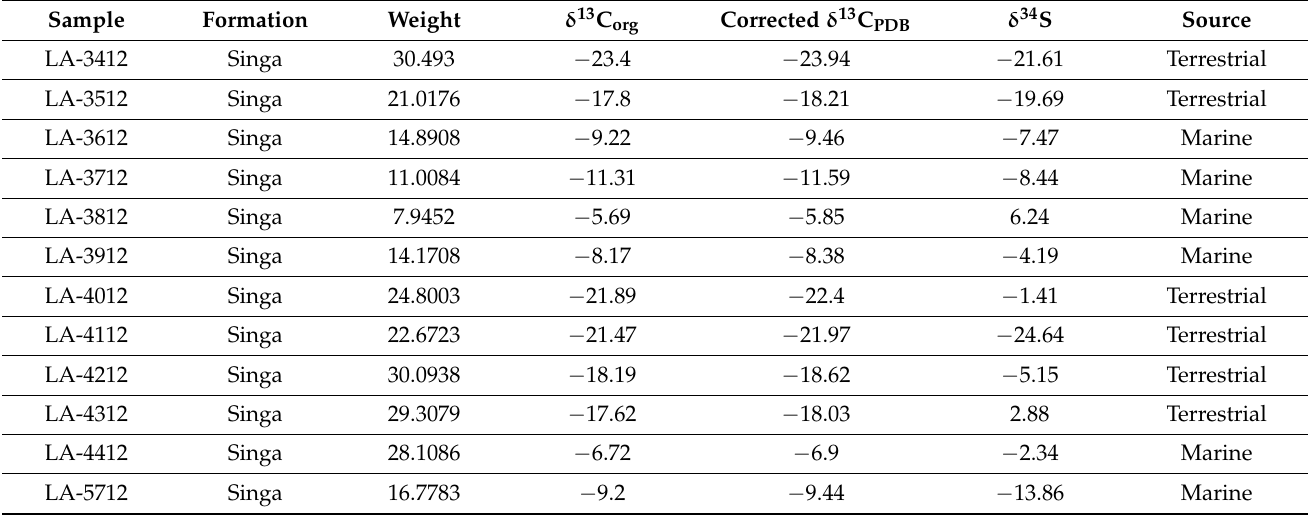
Table 4. Carbon and sulfur isotope composition from the black mudstones of Singa Formation, Malaysia.